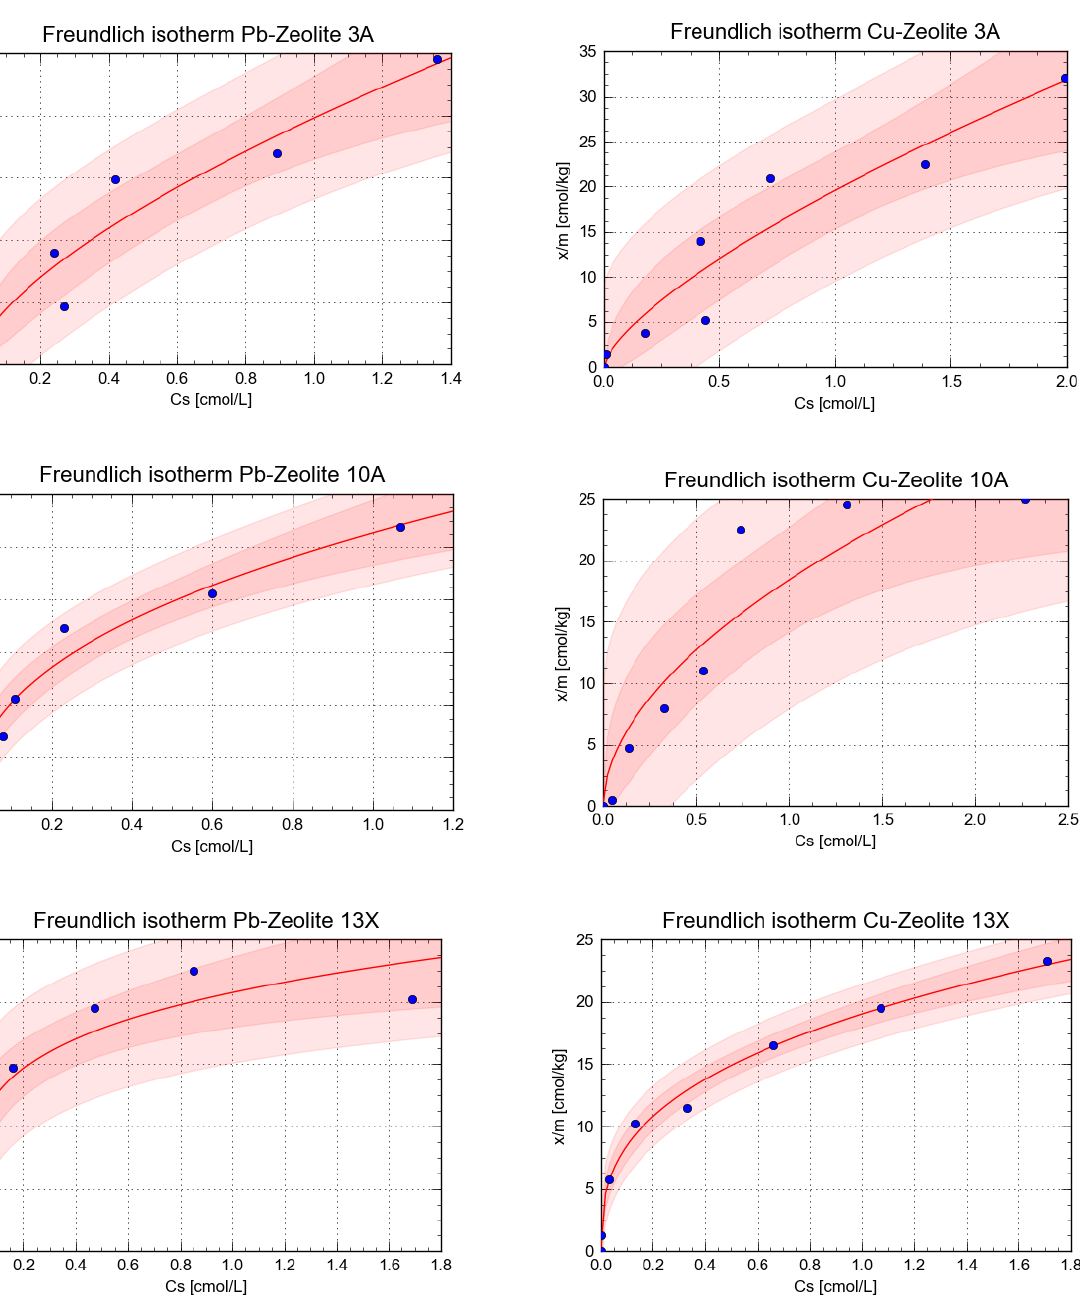
Figure 2. The Freundlich isotherms obtained in the study for sorption of Pb 2+ and Cu 2+ onto tested synthetic zeolites. The arrangement of the tested minerals for their strength and extent of sorption, from strongest to the weakest, returned the following order: for Pb 2+